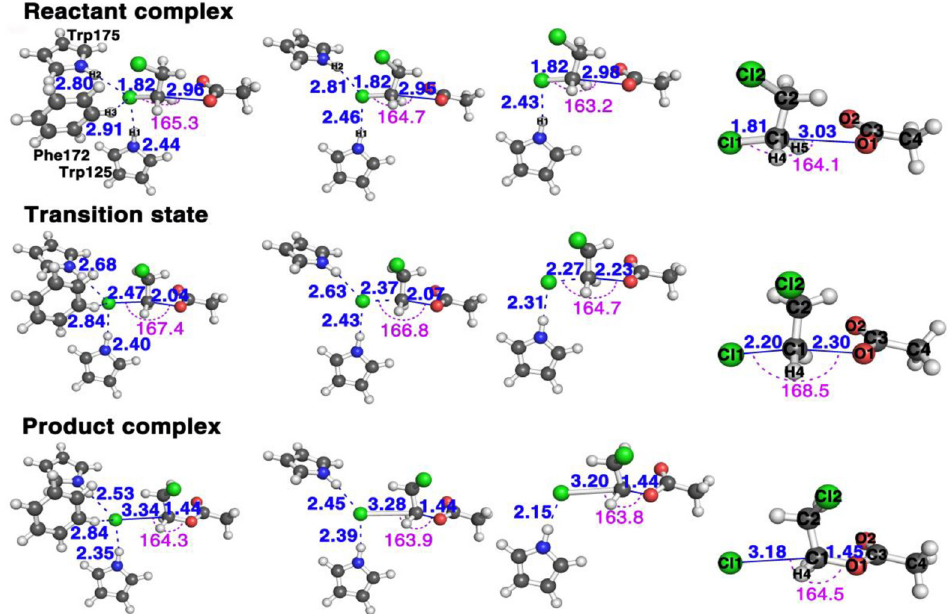
Figure 2. The structural comparison of the three stationary points, reactants (top row), transition states (middle row), and products (bottom row) of AcO − + DCE reaction in the presence of, from left column to right column, three (Trp125 + Phe172 + Trp175), two (Trp125 + Trp175), one (Trp125) and zero residues, respectively (see Figures S1–S5 for more detailed information of these geometries in the Supplementary Materials).